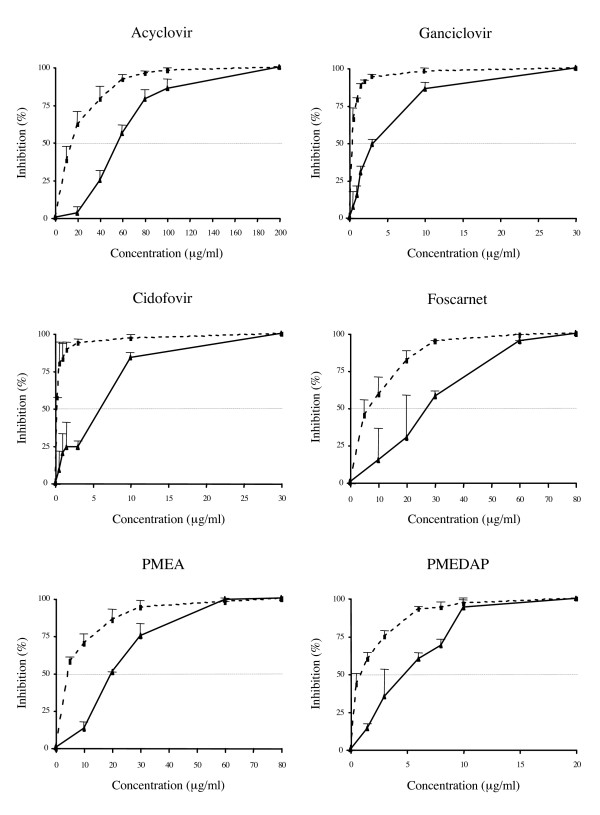
Activity of six antiviral drugs against feline herpesvirus 1. Dose-response curves are shown representing the activity of six antiviral drugs to reduce the number (solid line) and size (dashed line) of feline herpesvirus 1-induced plaques in Crandell-Rees feline kidney cells. Data are presented as the mean value of three independent experiments + standard deviation.